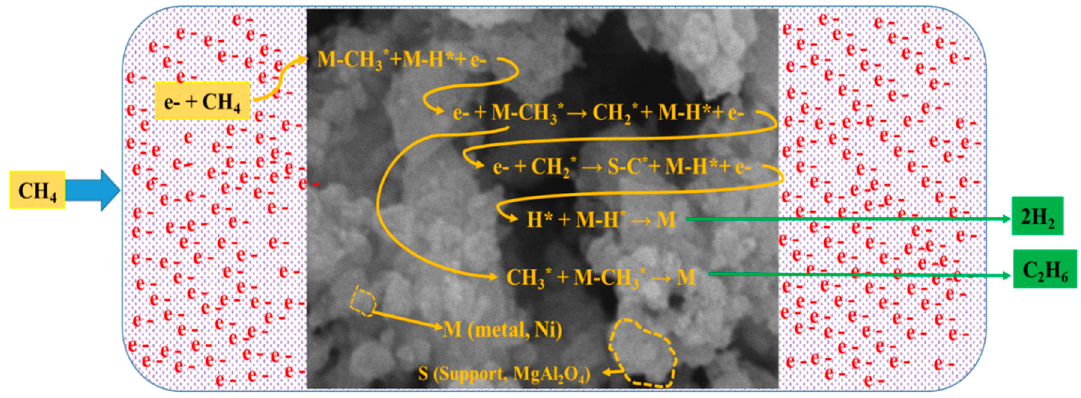
Figure 8. Proposed reaction mechanism for plasma-catalytic methane cracking over Ni/MgAl 2 O 4.